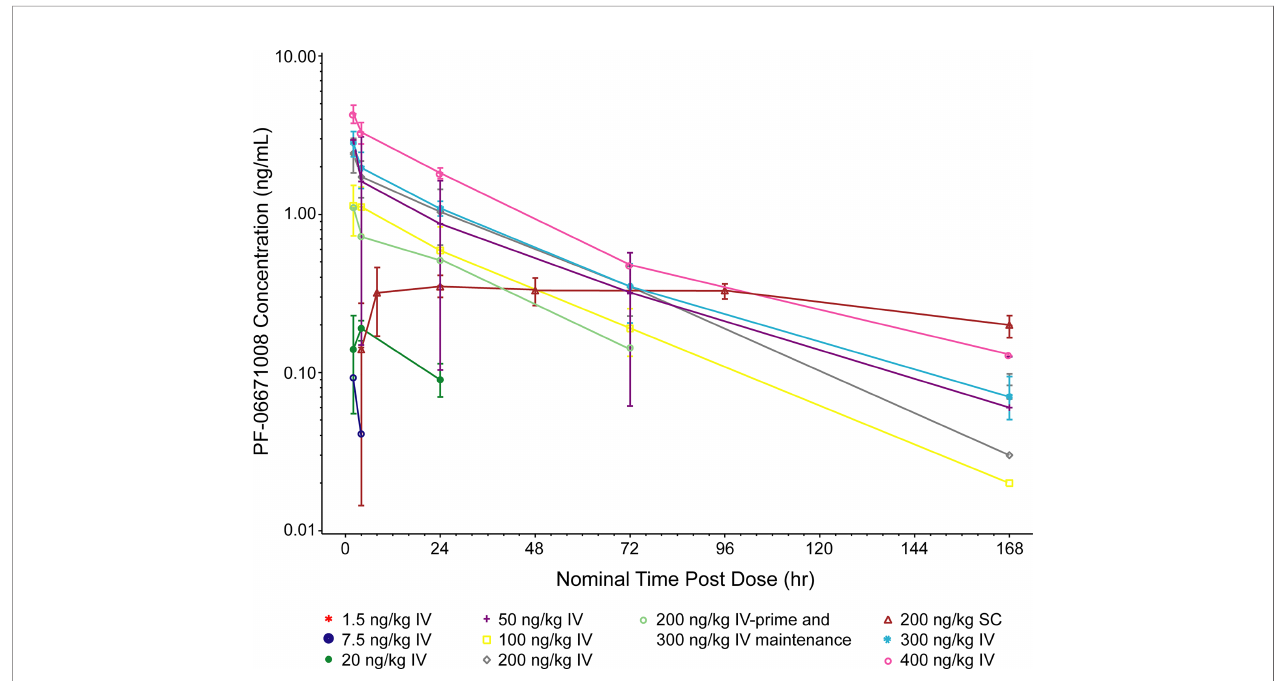
FIGURE 2 | Pharmacokinetics of PF-06671008. 168 hr is equivalent to cycle 1 day 8, 0 hr. PF-06671008 was not detectable following the 1.5 ng/kg dose. The lower limit of quanti fi cation is 0.0500 ng/mL. Summary statistics were calculated by setting concentration values below the lower limit of quanti fi cation to zero. IV, intravenous; SC,